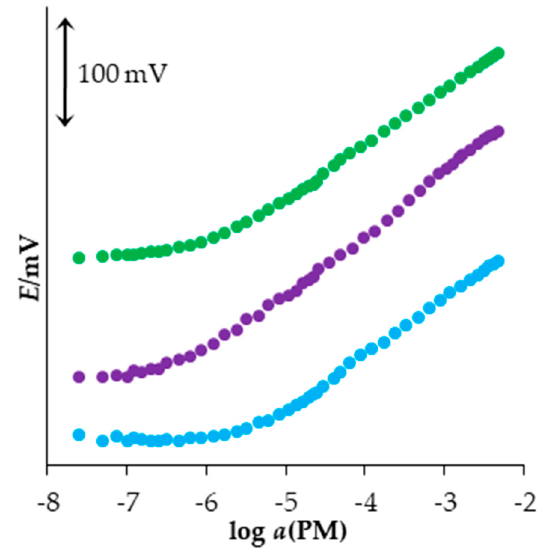
Figure 2. Responses to PM obtained using the PM sensors with different content of sensor material ( ● 2%, ● 4%, and ● 6%). Some curves are displaced vertically for clarity. Table 3. Statistics of the response characteristics of the PM sensors with different content of sensor material, to PM 1